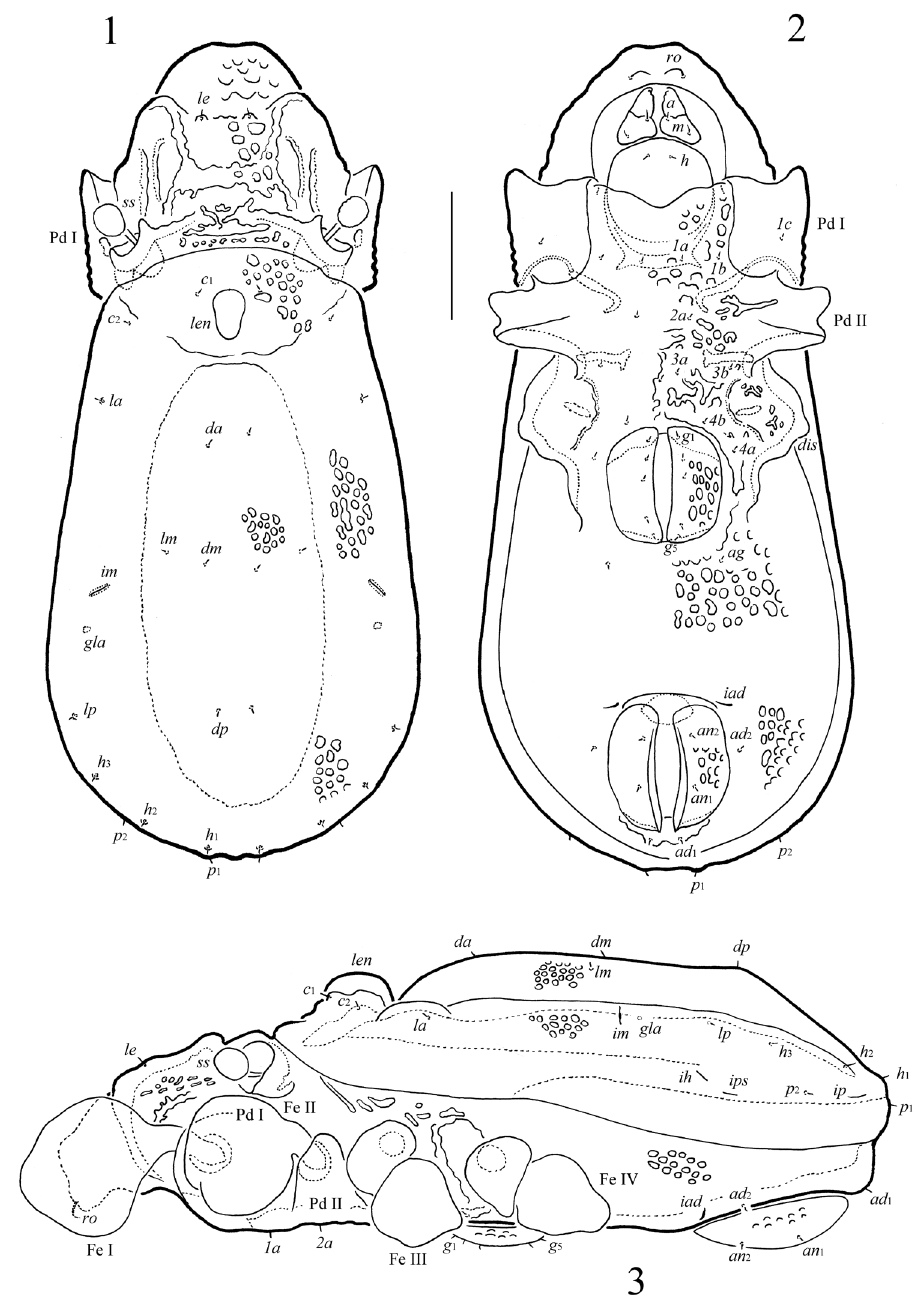
Figures 1–3. Scapheremaeus gibbus sp. n., adult: 1 dorsal view 2 ventral view (legs not shown) 3 lateral view (gnathosoma and legs except basal parts not shown). Scale bar 50